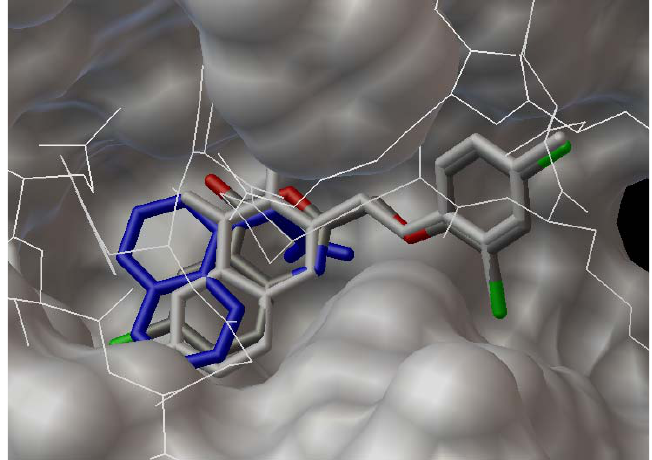
Figure 3. A top view of the docked conformations of 3 o (in atomic color) and 4 i (in grey) along with NAA (in blue) from the TIR1/NAA crystal complex in the binding site of the receptor TIR1. The above line structure is the Aux/IAA substrate